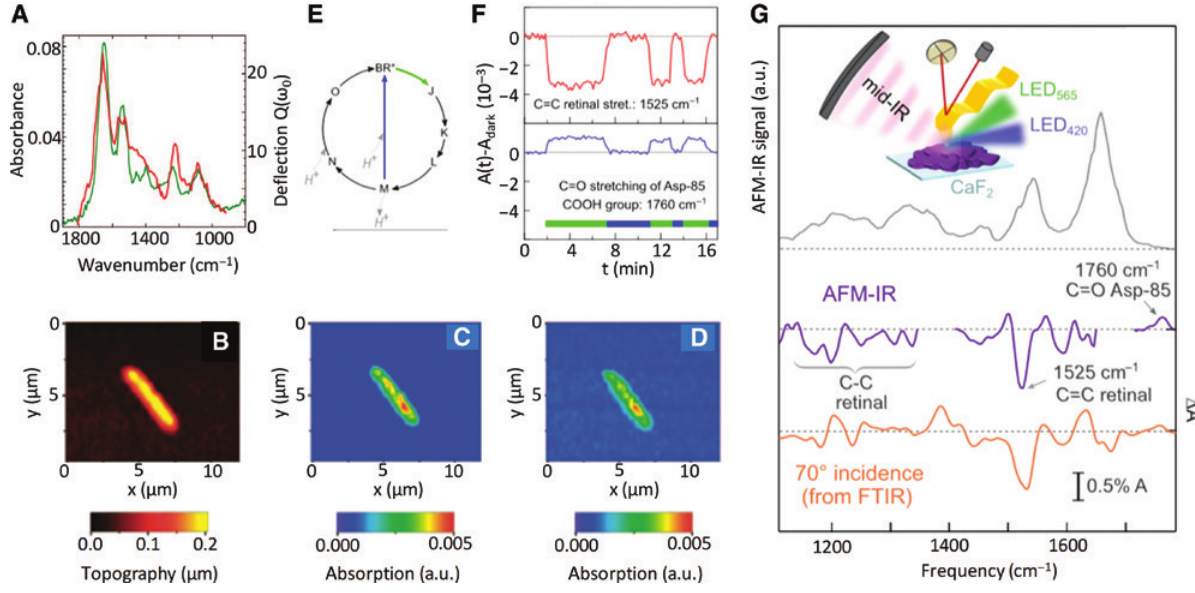
Figure 7: Microscopy for biological samples [23, 60]. (A) FTIR spectra of an Escherichia coli culture and (green curve) AFM-IR spectrum of a single E. coli bacterium. (B–D) Topography, AFM-IR image at 1660 cm −1 (amide I absorption peak), and AFM-IR image at 1240 cm −1 (amide III absorption peak). (E) Bacteriorhodopsin photo- cycle. (F) FTIR signal at 1525 (C = C peak) and 1760 cm −1 (COOH group peak) while alternately turning on and off the green and blue LEDs after a 2 min dark period. (G) AFM-IR spectrum of a thick-film region ( d = 1 μ m) located in a purple-membrane (gray curve), AFM-IR difference- spectra Δ A = A – A (violet curve), and FTIR difference-spectrum; the schematic of experiment is shown green blue